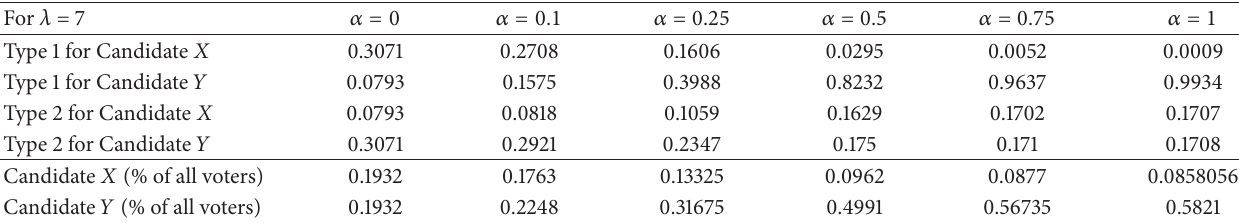
Table 5: Predicted turnout probabilities for different levels of ethical preferences ( 𝛼